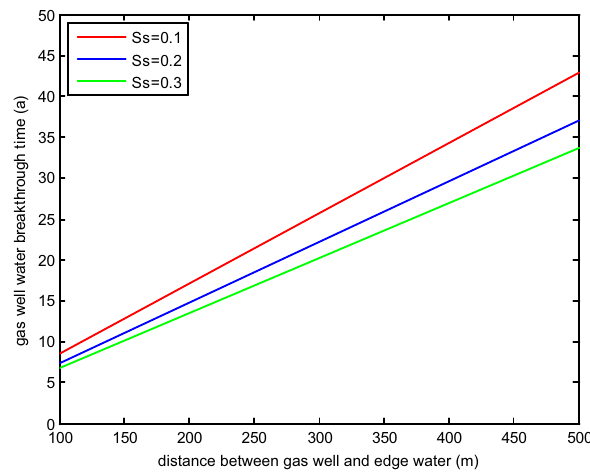
Fig. 3 The effect of sulfur deposition on water breakthrough time